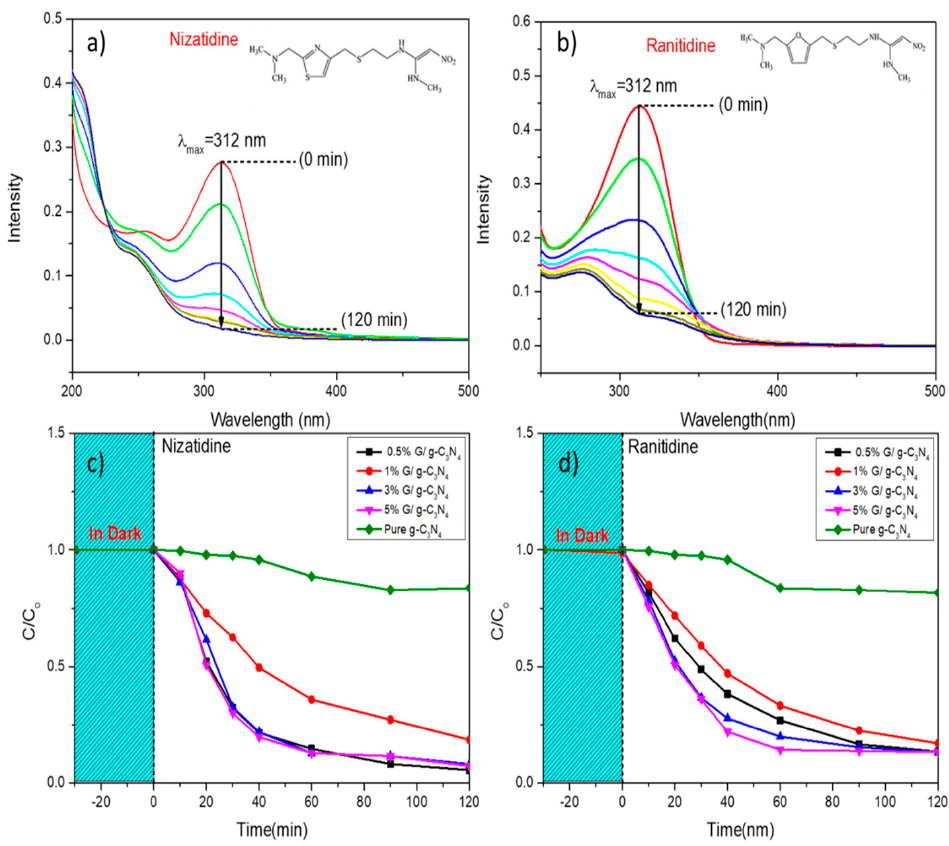
Figure 8. ( a ) The degradation rate of nizatidine and ( b ) ranitidine at an initial concentration of 5 mg/L and pH = 5.6 with 5% Gr/g-C 3 N 4 . ( c , d ) C/C o Plots for nizatidine and ranitidine, respectively, under UV irradiation.